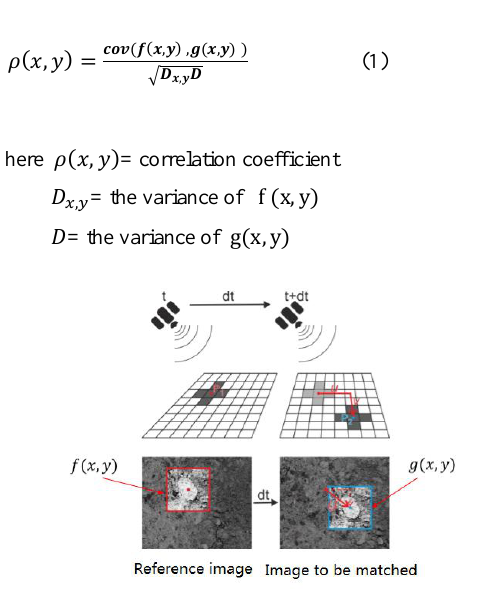
Fig. 4 Illustration of the MCC method. The rectangle with the red outline in the first image is the manually selected feature and the rectangle with the blue outline in the second image is